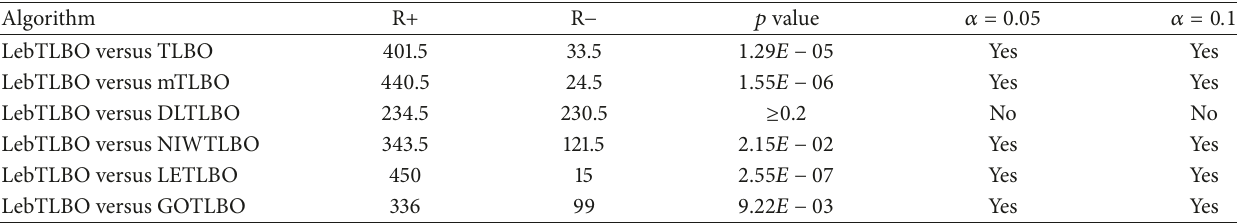
Table 3: Multiple-problem Wilcoxon signed-rank between LebTLBO and other TLBO algorithms.